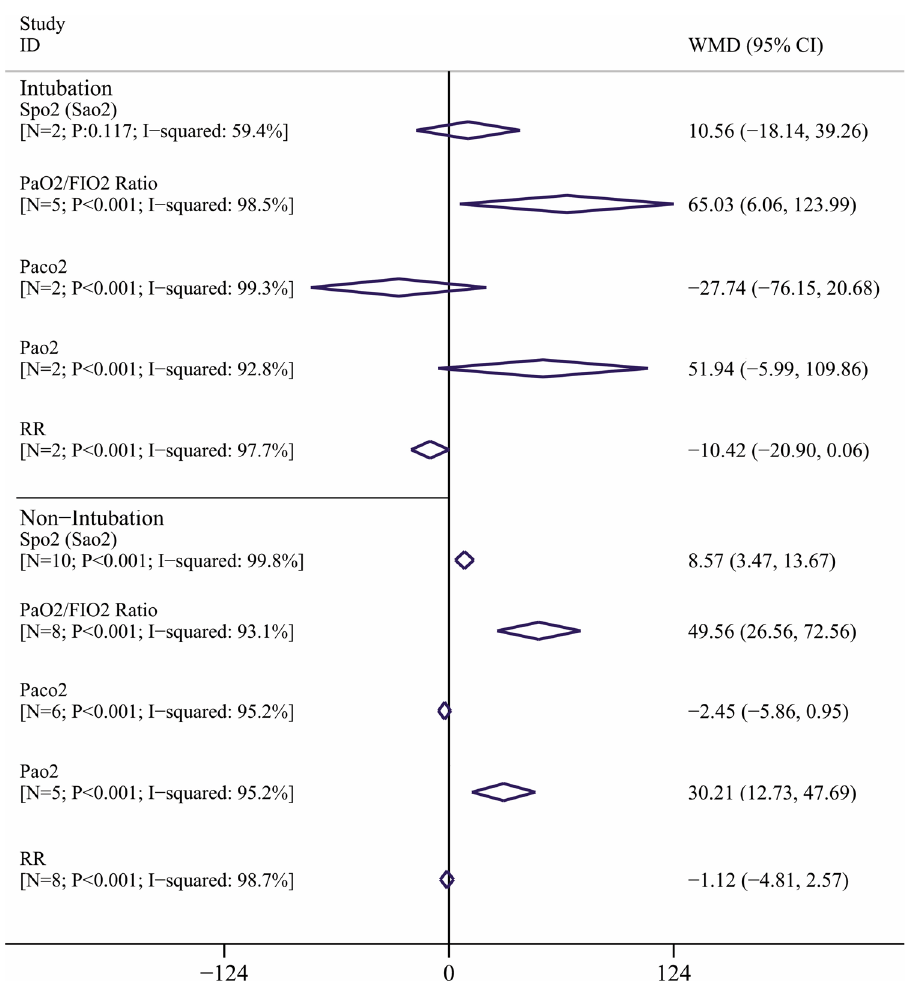
Figure 5. Pooled mean difference and 95% confidence interval of respiratory parameters based on the random effects model in different ventilation status. The diamond mark illustrates the pooled